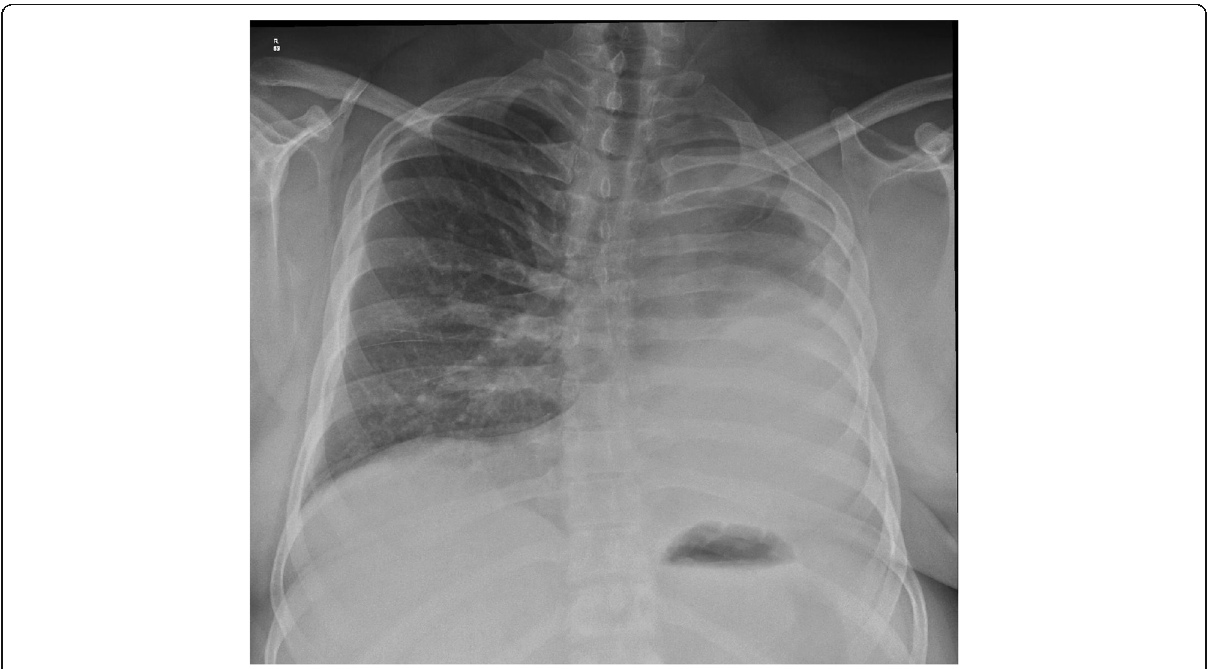
Fig. 1 Chest radiograph in frontal projection showing homogenous opacity of left hemithorax with mediastinal shift and contralateral herniation of right lung into left upper